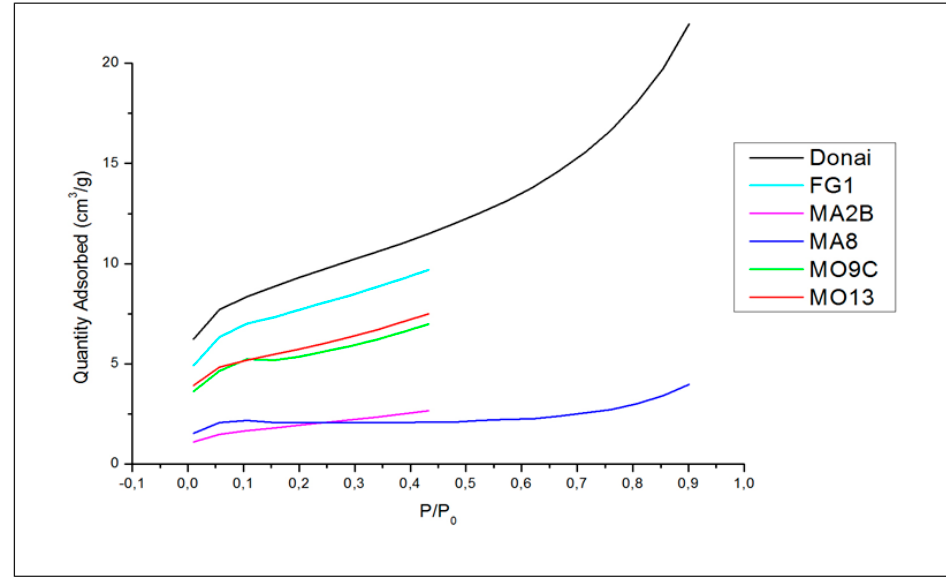
Figure 4. Nitrogen adsorption isotherms on serpentinite samples at 77 K.